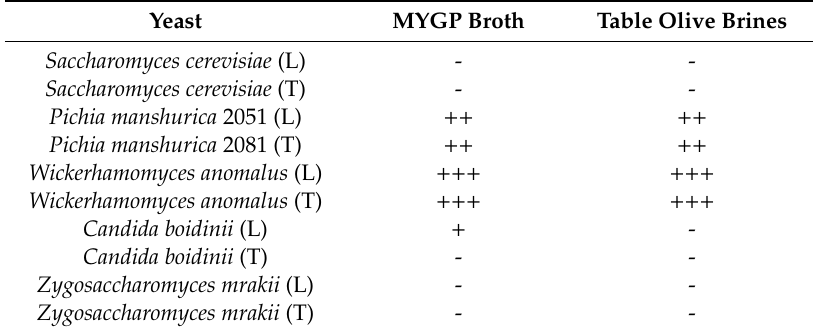
Table 1. Yeast film production in vitro by the predominant species isolated from brines after 10 months of fermentation in industrial barrels. Yeast